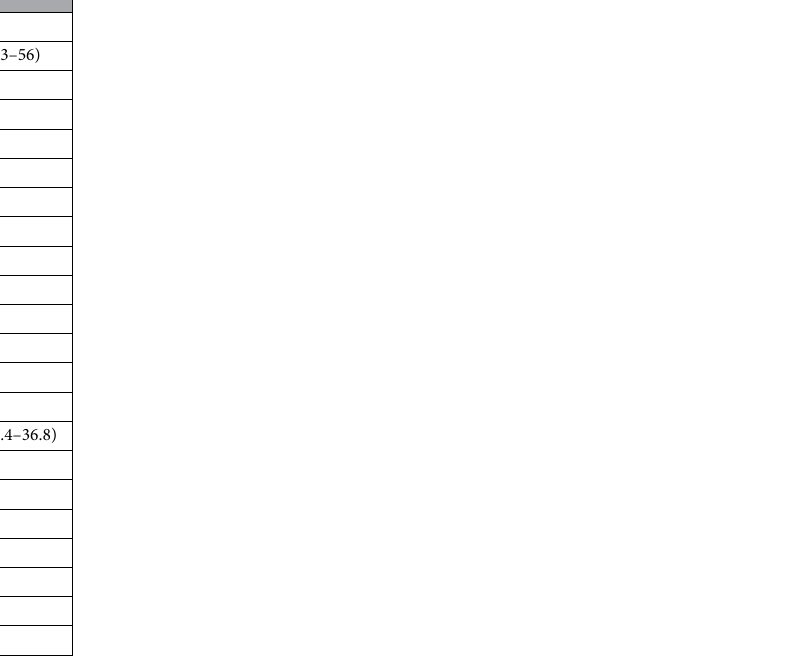
Table 3. Demographic data of 12 patients evaluated bone metabolic markers with serum